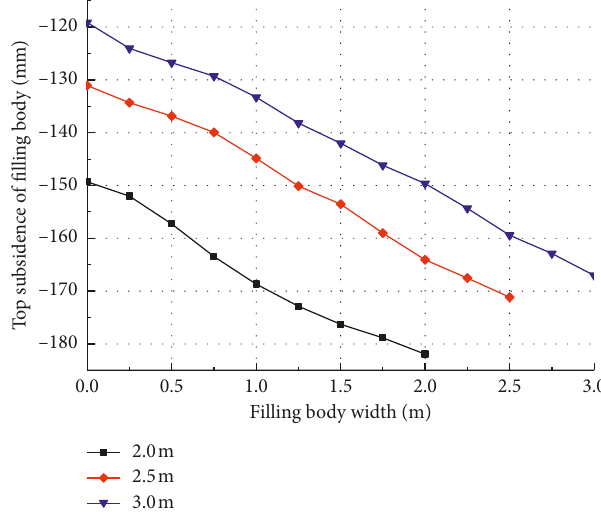
Figure 12: Relations between top subsidence and width of the filling body.